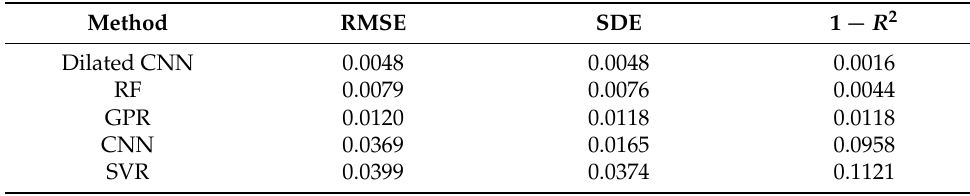
Table 3. Prediction errors of different baseline